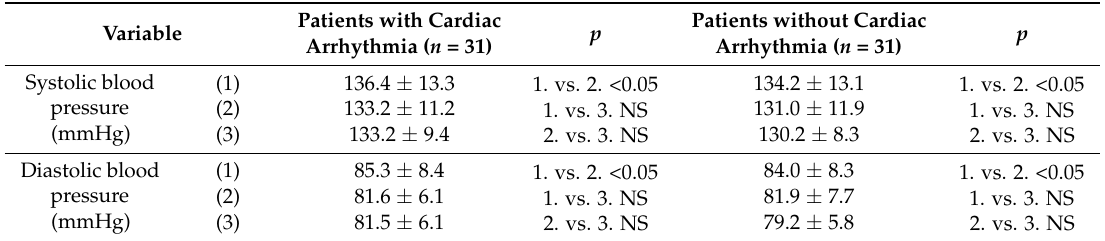
Table 4. Results of blood pressure measurements in overactive bladder (OAB) patients during the